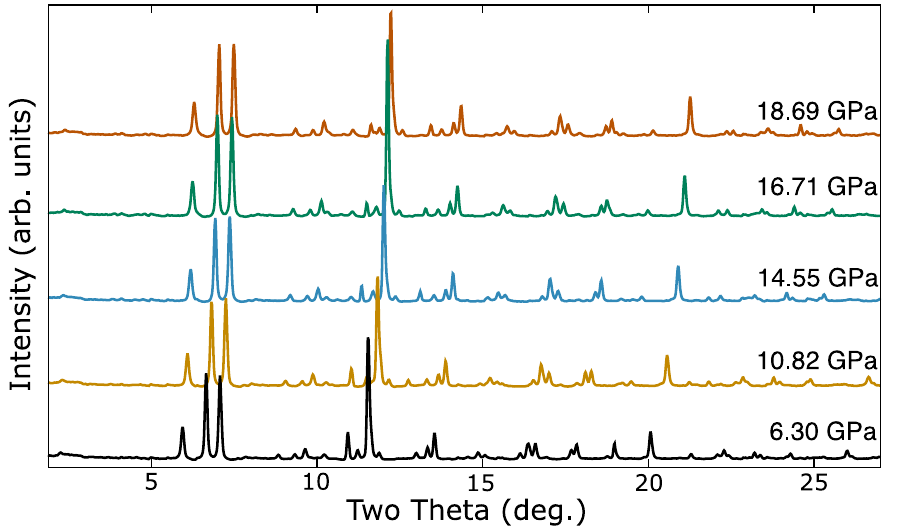
Figure 1. Pressure evolution of the background subtracted integrated diffraction pattern of the lithium– palladium intermetallic at ambient